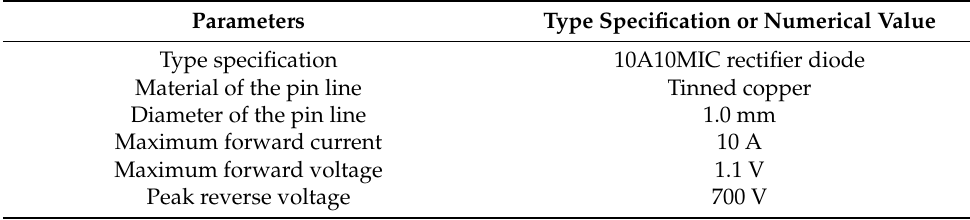
Table 2. The type and parameters of the bypass